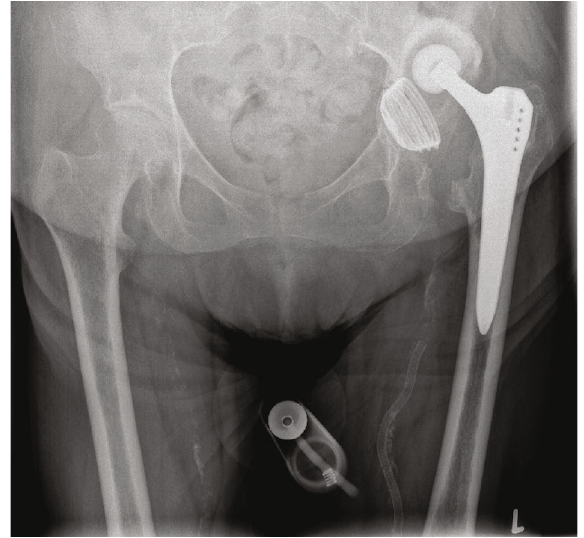
Figure 1: The pelvic radiographs demonstrate dislocation of left total hip replacement, protrusio acetabuli, formation of pseudoarthrosis, and gross loosening of the screw cup. No signs of loosening or fracture of the Zweymüller type femoral stem. Incidental femoral stent on the